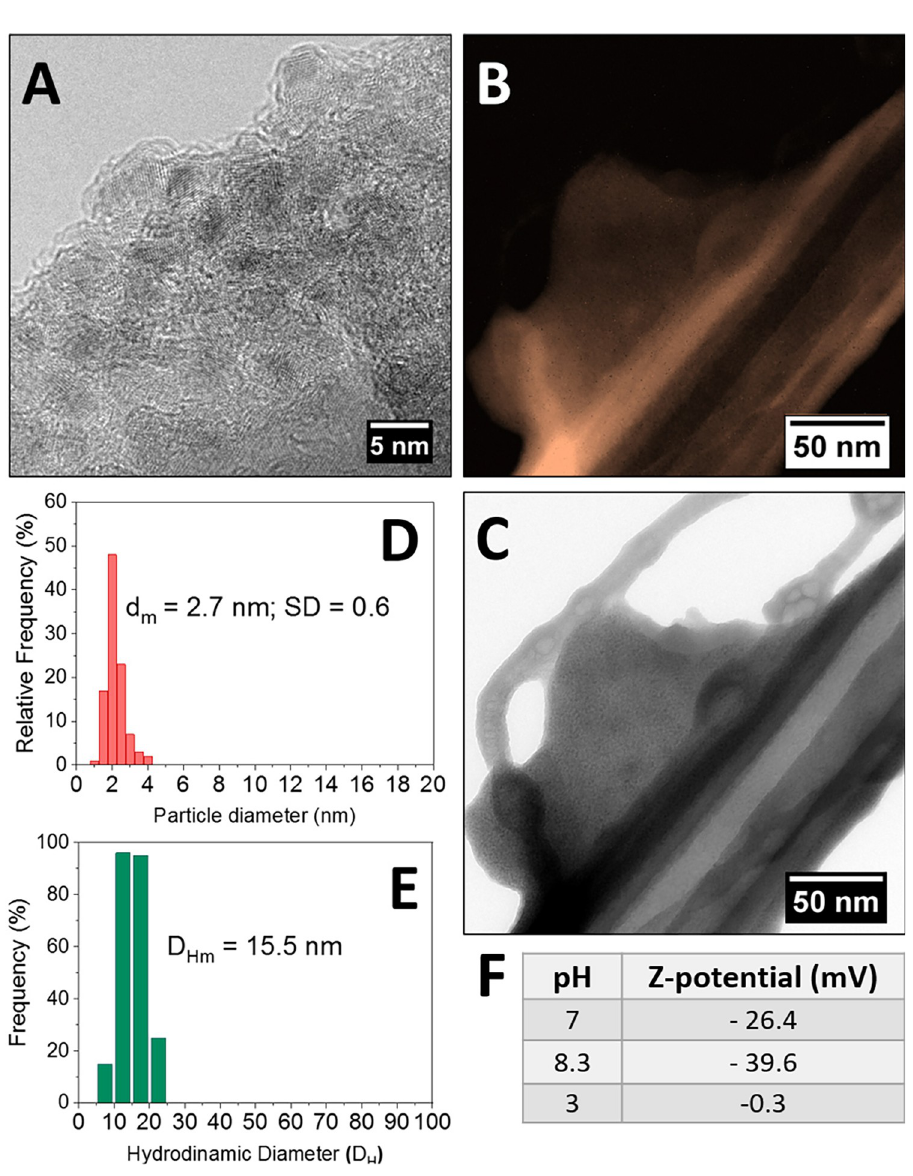
Fig 2. HR-TEM image of Glc-SPIONs (A); false-color EF-TEM images filtered at 713 eV providing Fe maps (B); reference TEM image (C); histogram of particle size distribution (D) and histogram of hydrodynamic diameter distributions (measured by DLS) (E); value of zeta potential of– 39.6 and– 0.3 mV at pH 8.3 and 3 (F).